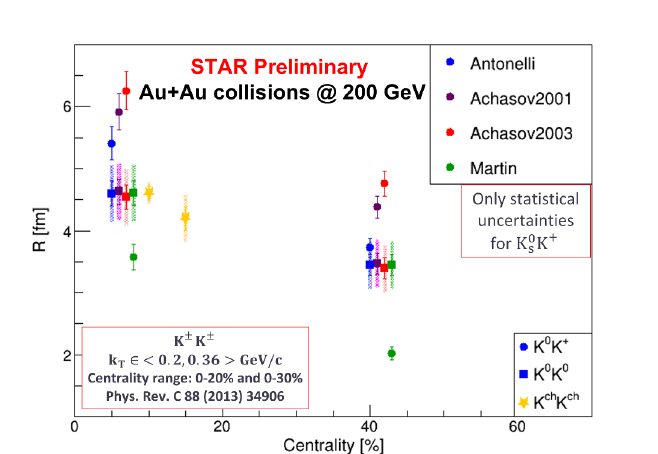
Figure 3. Centrality dependence of the particle emitting source sizes for the K ± K ± [6], K 0 K 0 K ± systems for Au + Au collisions at S K 0 K + , the squared markers correspond to K 0 S Di ff erent colors describe di ff erent Lednicky-Lyuboshitz parametrizations. For K 0 uncertainties are